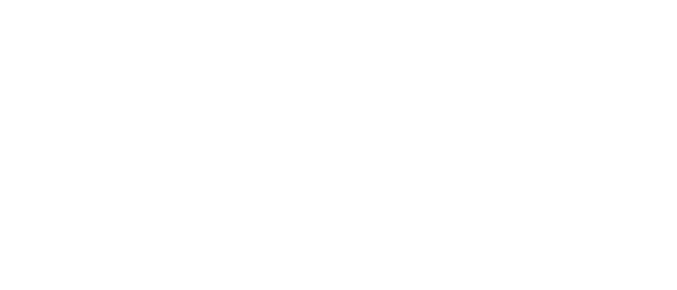
TABLE 5 | Chemical analyses of shoot and root tissues of Adhatoda vasica grown in different concentrations of quarry waste. Treatment Shoot tissues